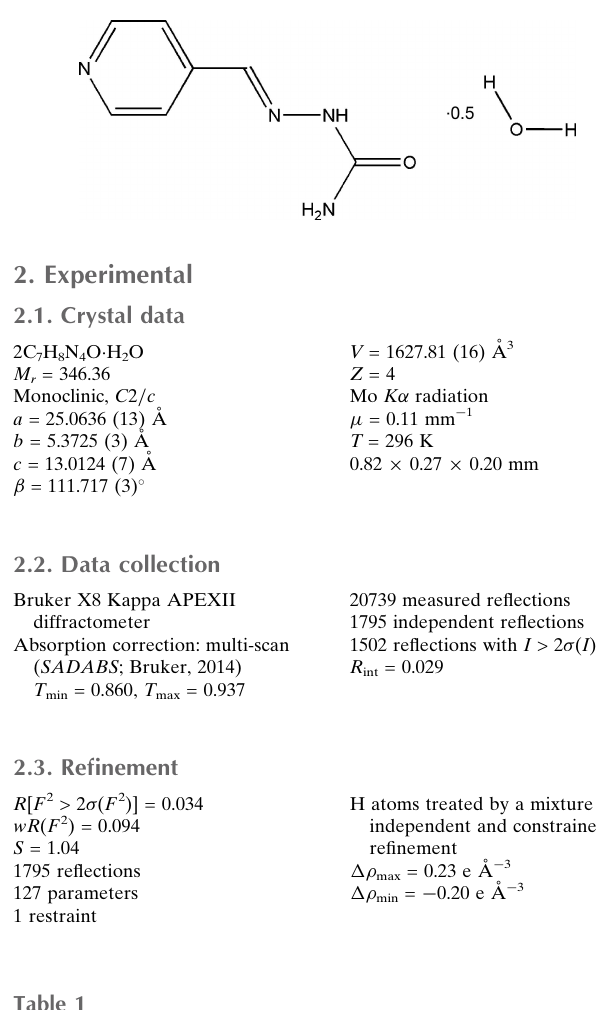
Hydrogen-bond geometry (A˚ , (cid:3)